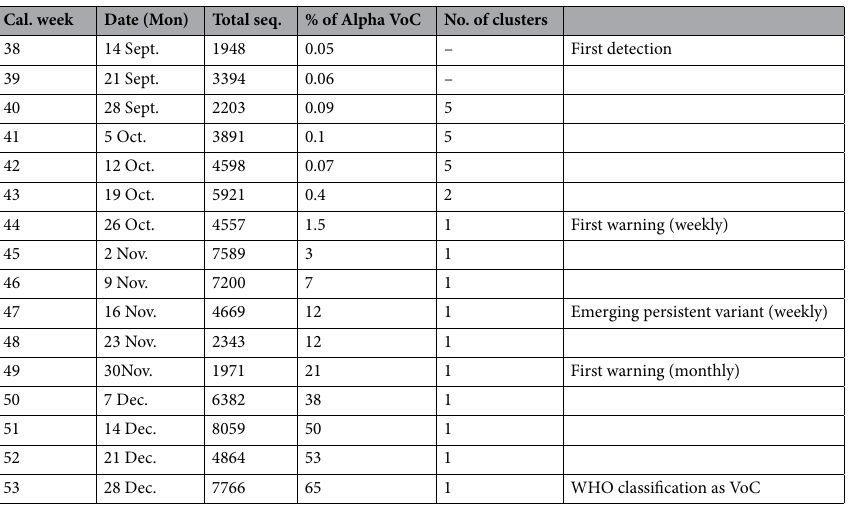
Table 1. Early warning for the Alpha VoC. Results of the ML analysis applied to weekly binned data after the first detection of the Alpha VoC in England. The columns contain the 2020 calendar week number, with the initial date (Monday), the total number of sequences in the dataset for each week and the percentage of Alpha VoC sequences identified a posteriori in the data. The fifth column contains the minimal number of clusters in the ML output that allows to isolate the Alpha VoC cases. When this indicator is equal to 1, an early warning can be issued (week 44). After 3 weeks of the cluster persisting, we identify it with an emerging variant (week 47). This date can be compared to the WHO classification decision (29 Dec., week